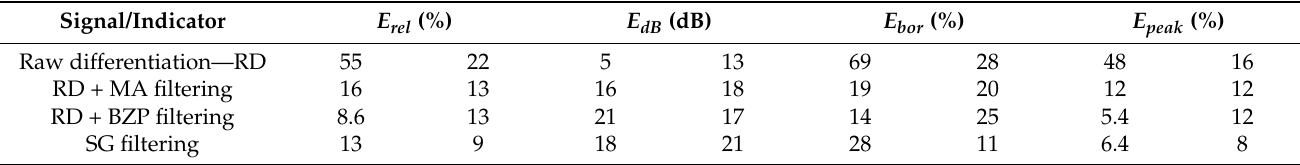
RD + BZP filtering